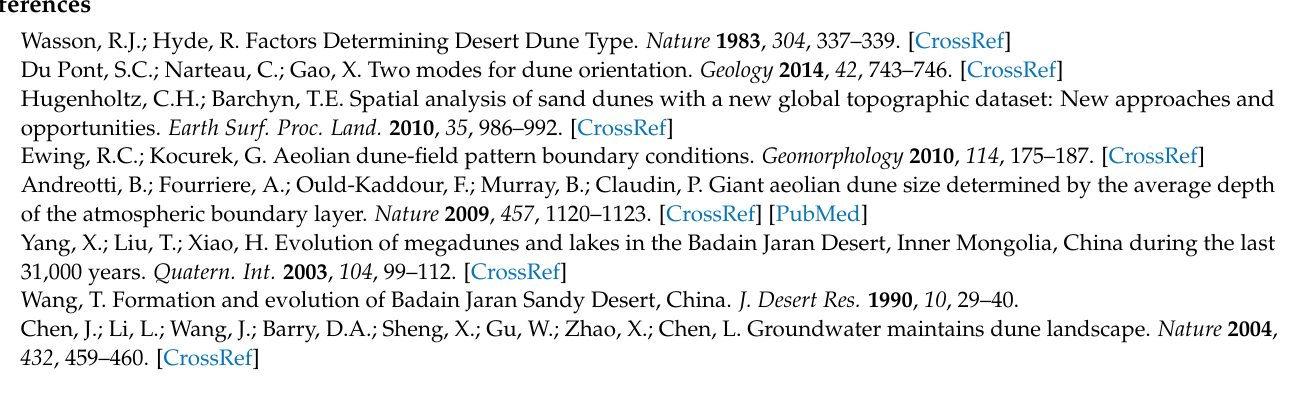
10.3390/rs13234915/s1. Figure S1: Sketch of the algorithm of the range of the surrounding area of a